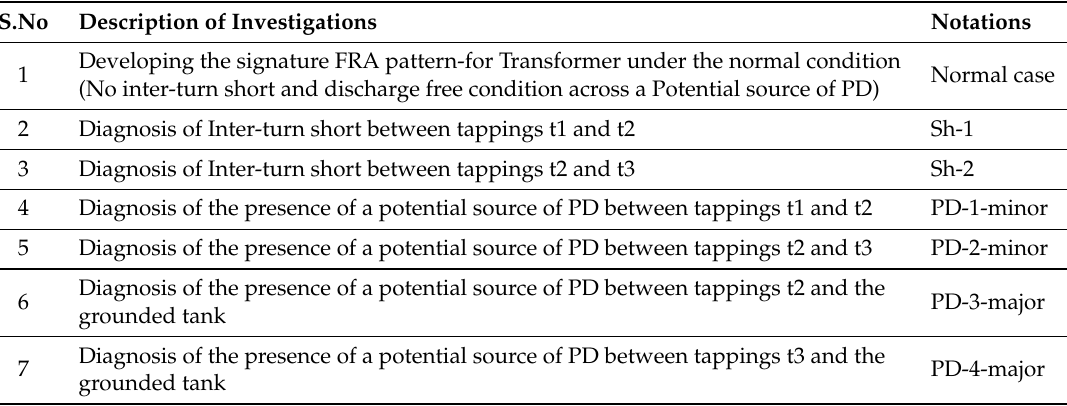
Table 1. Details of the investigations and their